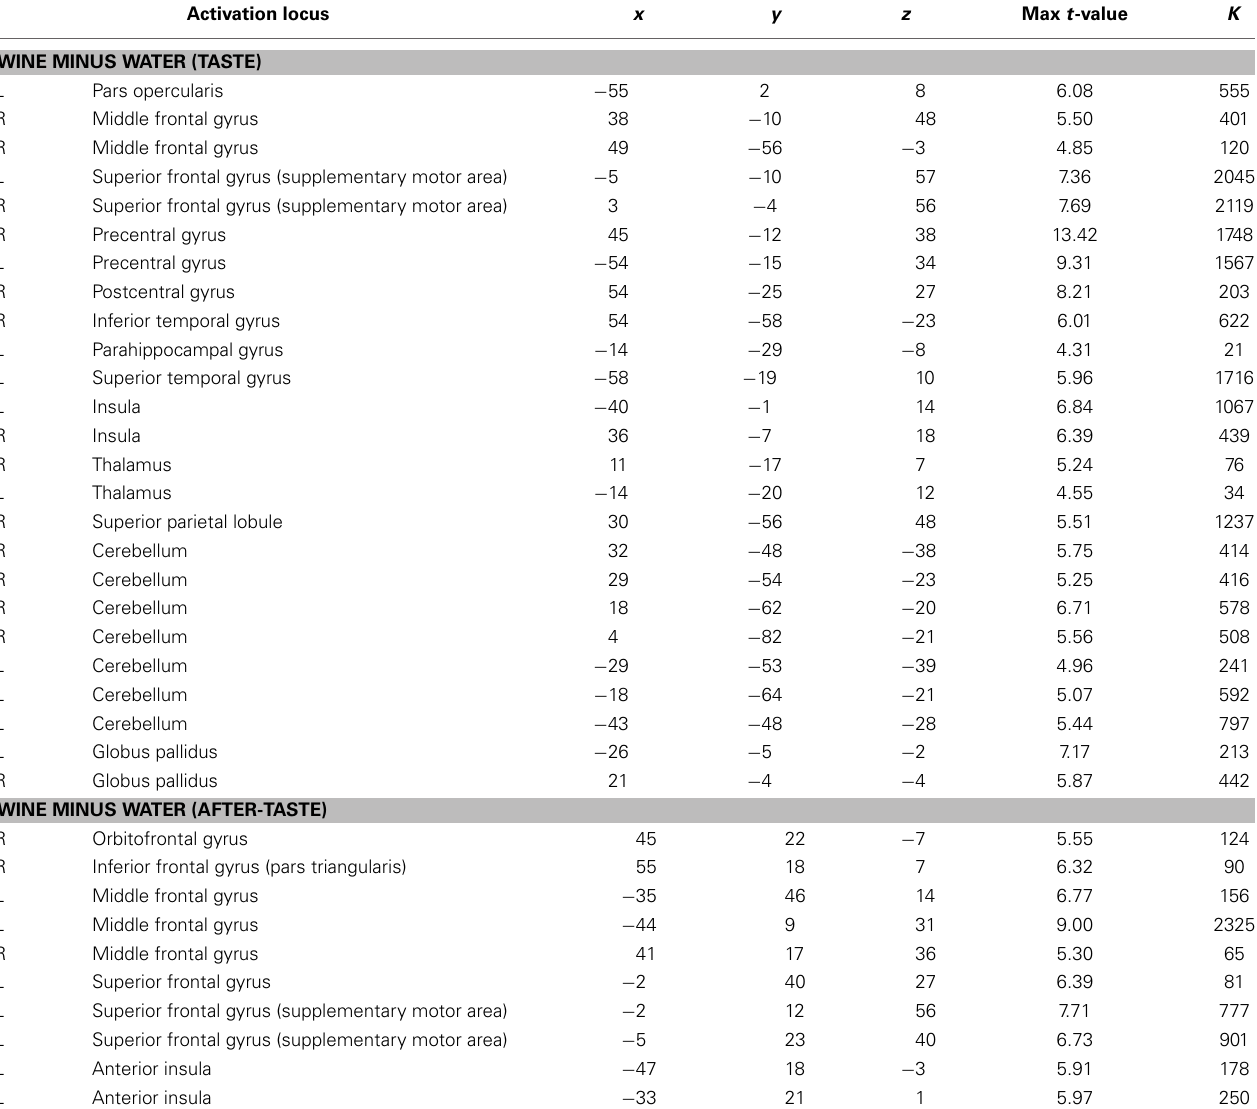
Table 1 | Wine minus water contrast for all subjects (simple main effects).